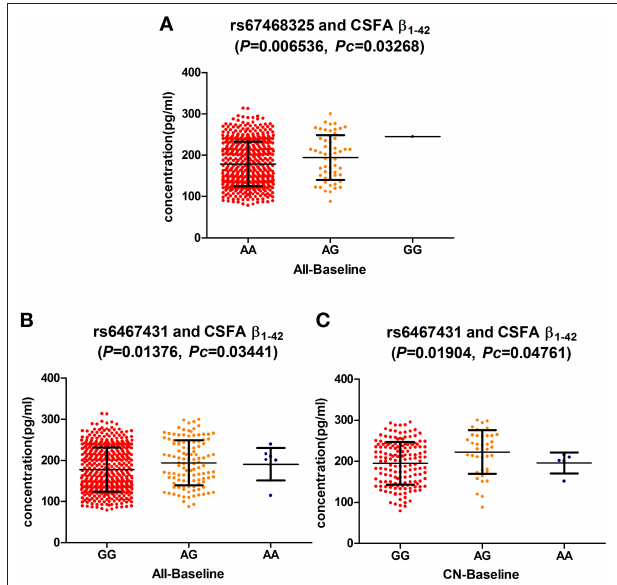
FIGURE 1 | (A) The significant association of PLXNA4 rs67468325 with Cerebrospinal fluid (CSF) A β 1-42 levels in the hybrid population. ( B) The significant association of PLXNA4 rs6467431 with Cerebrospinal fluid (CSF) A β 1-42 levels in the hybrid population. (C) The significant association of PLXNA4 rs6467431 with Cerebrospinal fluid (CSF) A β 1-42 levels in the CN